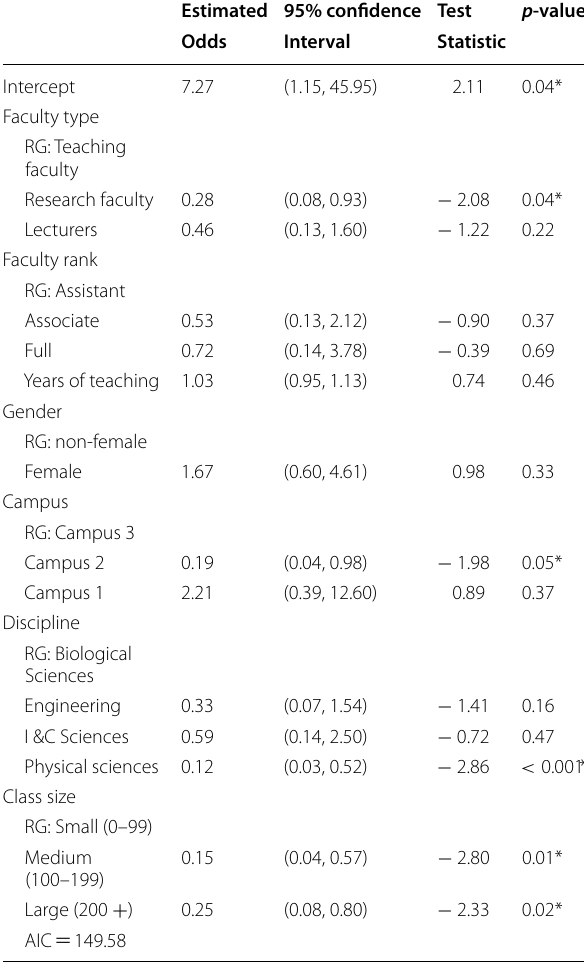
Table 6 Logistic regression model for active-learning